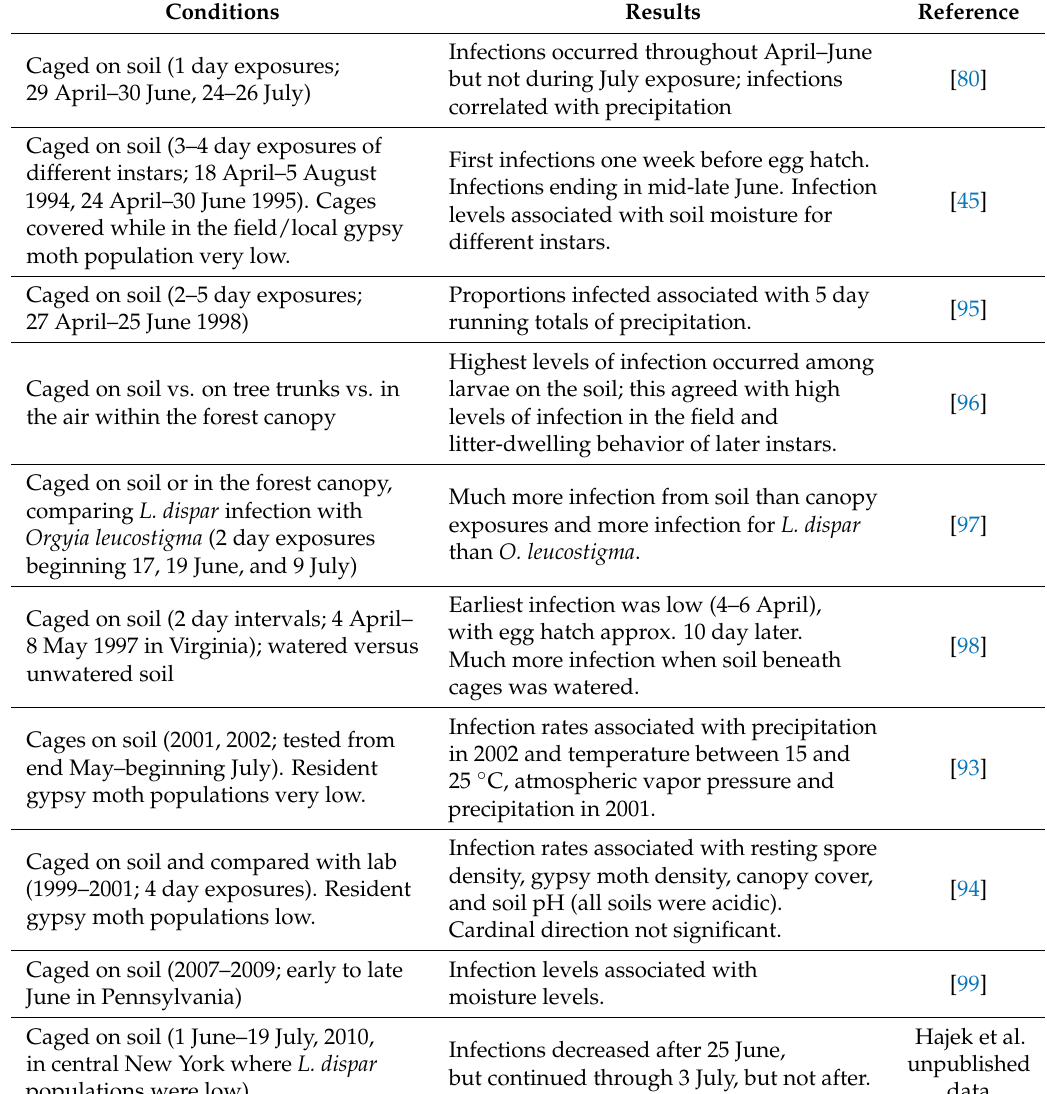
Table 3. Bioassays conducted by exposing caged Lymantria dispar larvae to soil bearing resting spores of Entomophaga maimaiga